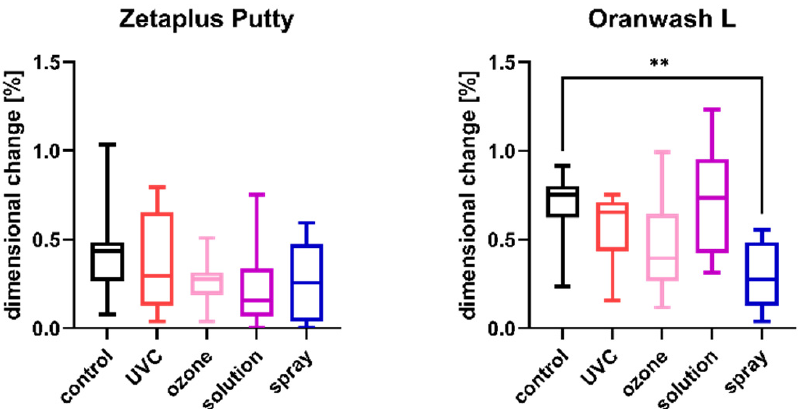
Figure 1. Linear dimensional change in C-silicones (Zetaplus Putty and Oranwash L) after disinfection using various methods; ** p < 0.01 for the comparison between the study (disinfected) groups and the control (nondisinfected) group.